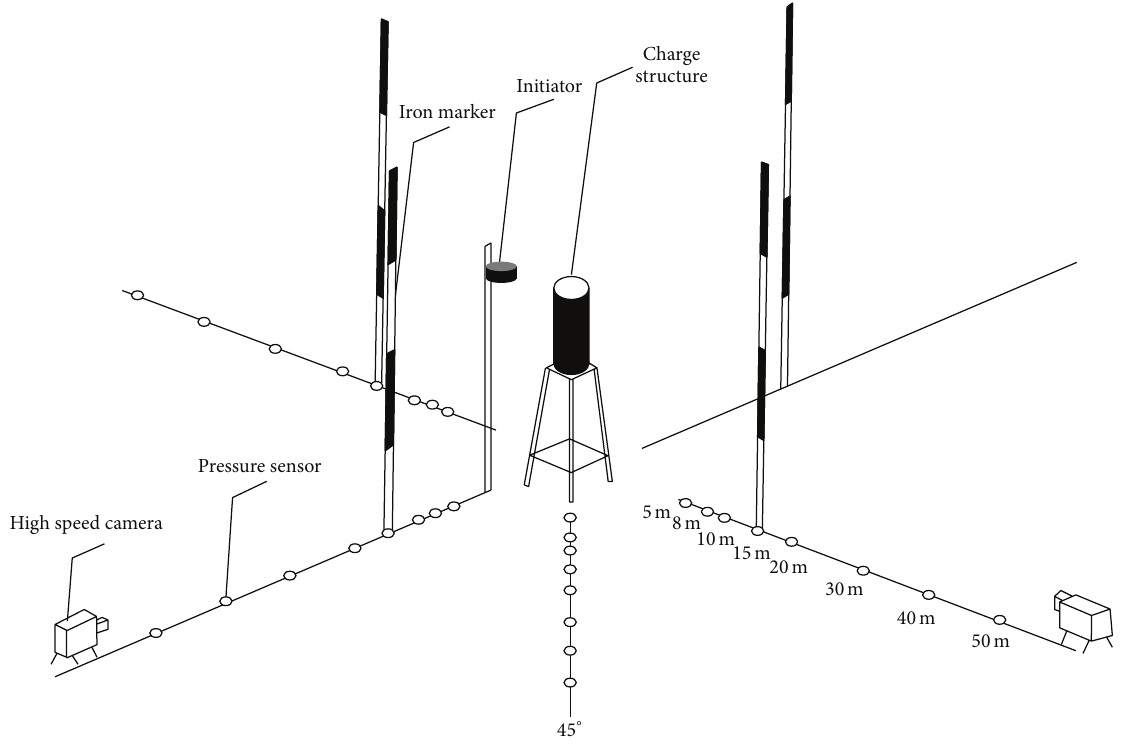
Figure 2: Experimental